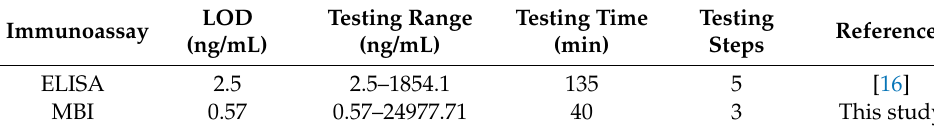
Table 2. The comparison of results from two immunoassay methods. Immunoassay